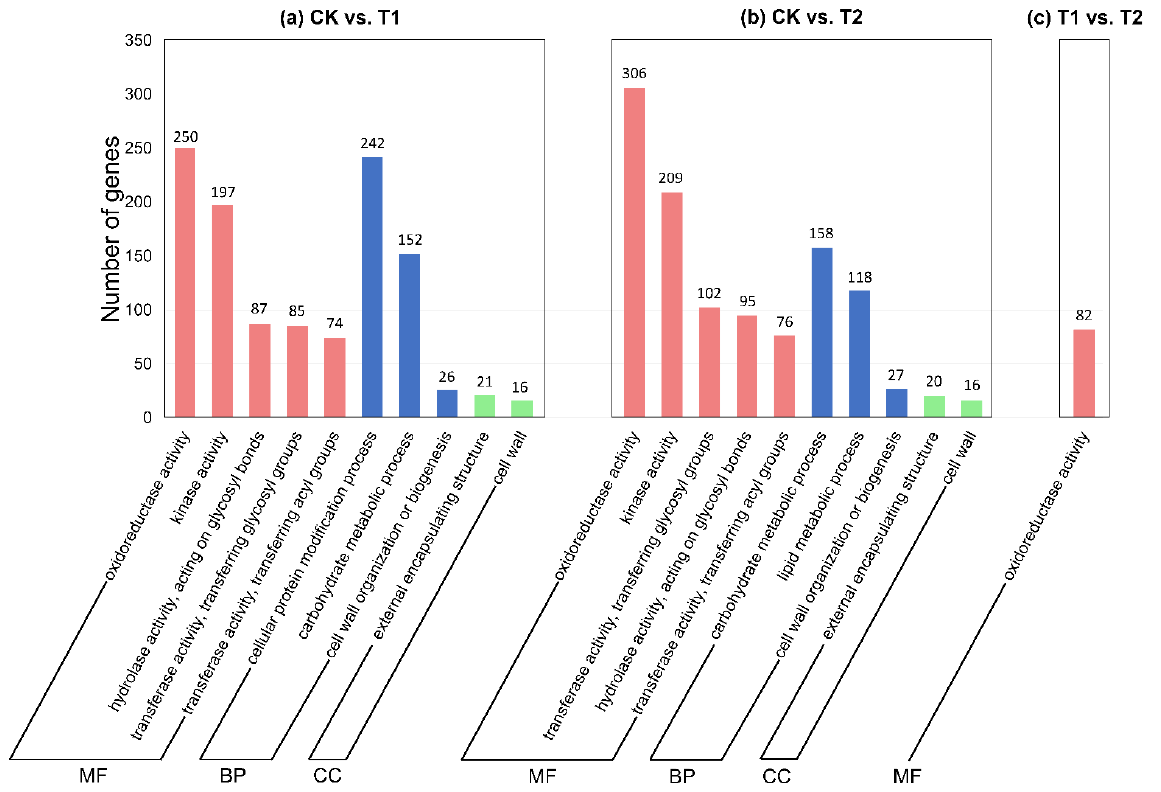
Figure 4. The GO enrichment analysis of differential expressed genes in Michelia macclurei . ( a – c ) represents the three comparisons of CK vs. T1, CK vs. T2, and T1 vs. T2.